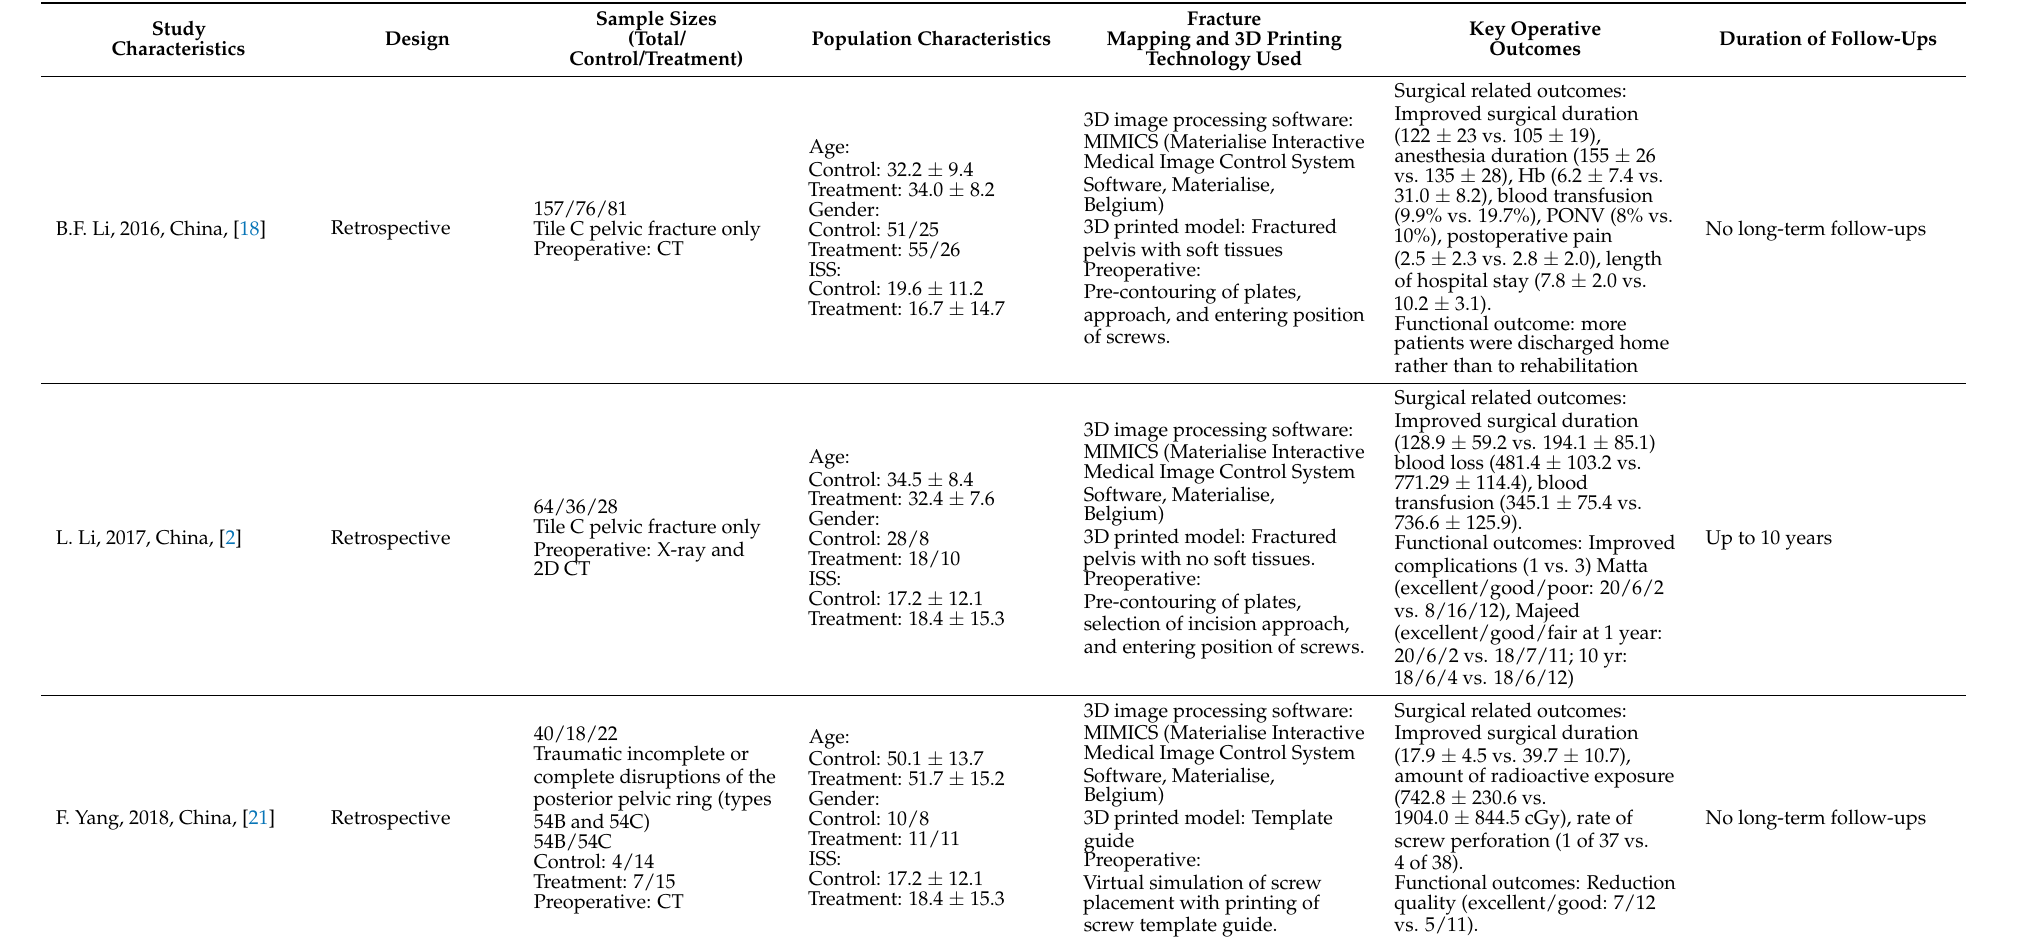
Table 1. Summary of findings ( n =